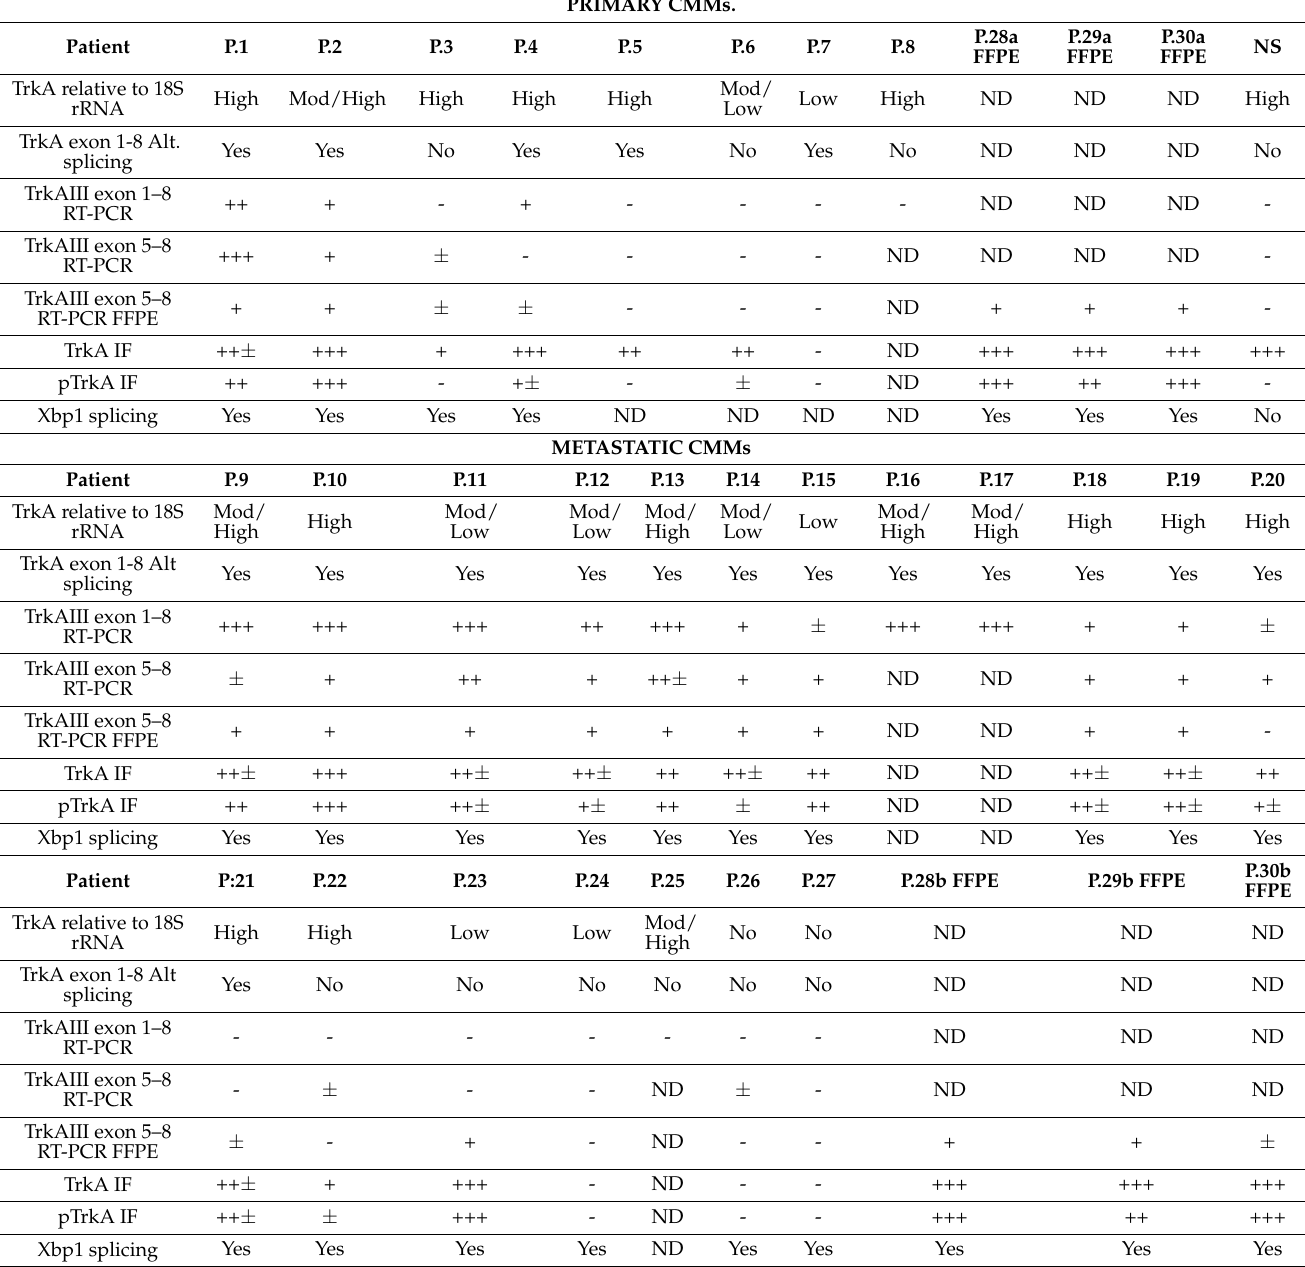
Table 1. Summary of associations between TrkA mRNA expression, alternative TrkA mRNA splicing and intracellular TrkA and phosphorylated TrkA IF immunoreactivity in primary and metastatic CMMs. Levels of TrkA relative to 18S rRNA RT-PCR products are displayed as: high, moderate (Mod), low or not detected (No). TrkA exon 1–8 alternative splicing is displayed as detected (Yes) or not detected (No). Relative levels of TrkAIII exon 1–8 (TrkAIII (ex 1–8) RT-PCR) and TrkAIII exon 5/8 splice junction RT-PCR products in snap-frozen (TrkAIII (ex 5/8) RT-PCR) and formalin-fixed paraffin-embedded tissues (TrkAIII (ex 5/8) RT-PCR FFPE), and TrkA (TrkA IF) and phosphorylated TrkA immunoreactivity (pTrkA IF), are displayed as high to low (+++ to +), very low ( ± ), or not detected (-). Unconventional Xbp-1 splicing is displayed as detected (Yes) or not detected (No) (see Supplemental Figures S1–S4 for CMM IF micrographs and RT-PCRs). Only formalin-fixed paraffin-embedded (FFPE) tissues were available for patients P.28a/b, P.29a/b and P.30a/b. ND refers to observations that were not carried out due to limited RNA and tissues. PRIMARY